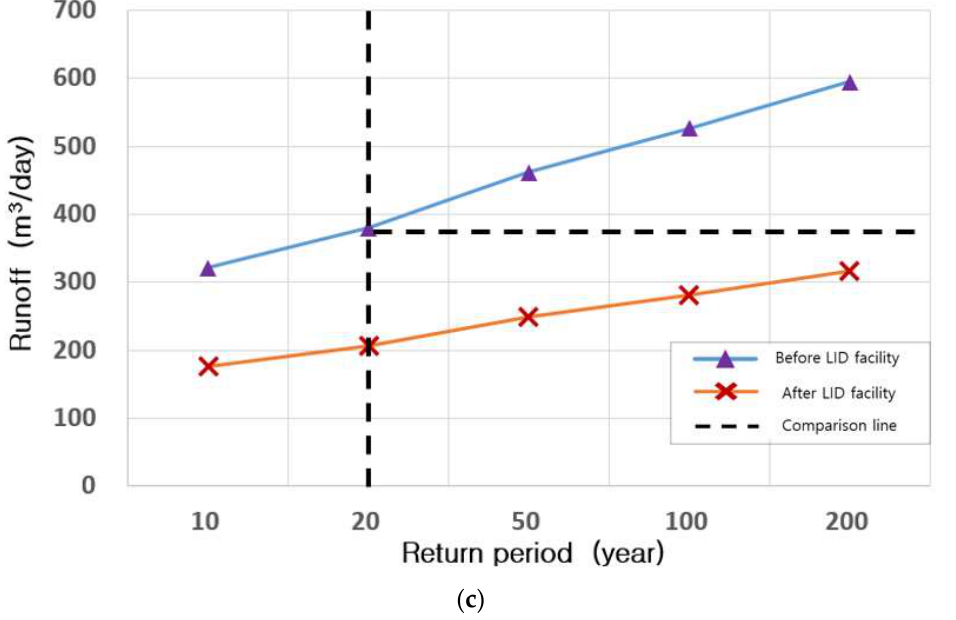
Figure 10. Change in runoff by return period in RCP 4.5 scenario: ( a ) 1988–2018 (year); ( b ) 1988–